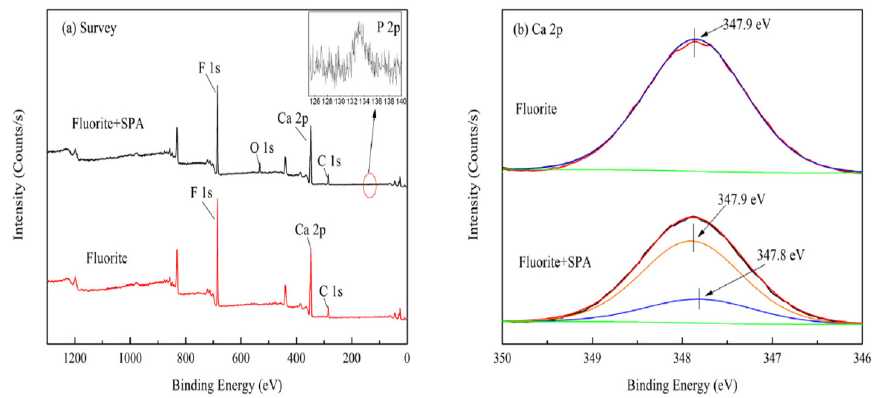
Figure 5. Survey spectra ( a ) and Ca 2p high-resolution spectra ( b ) of fluorite and fluorite treated with SPA.